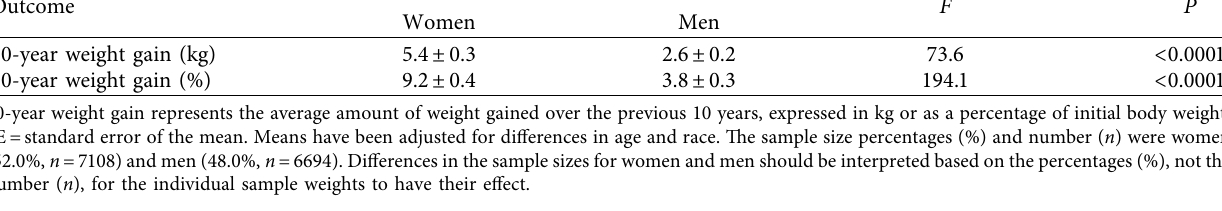
Table 4: Mean differences in 10-year weight gain between women and men, after adjusting for the covariates. Outcome